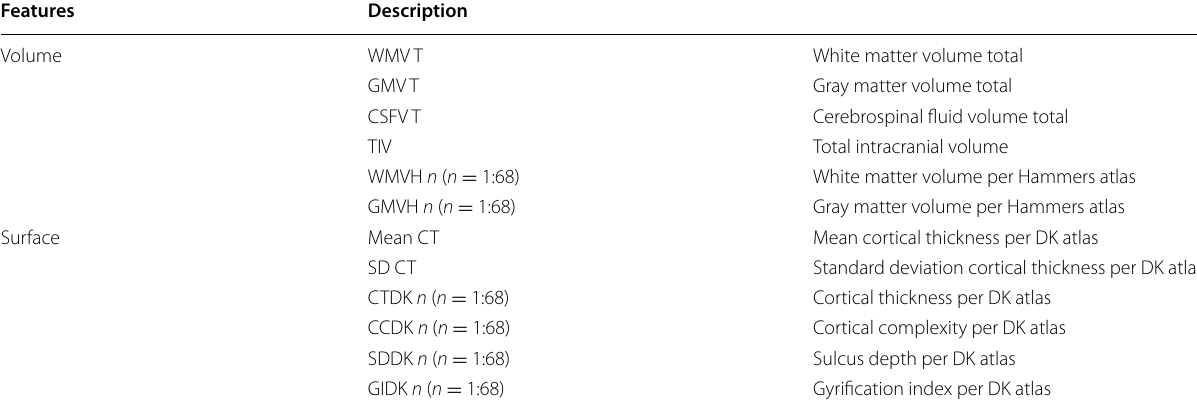
Table 2 Volume and surface features extracted from the structural magnetic resonance images Features